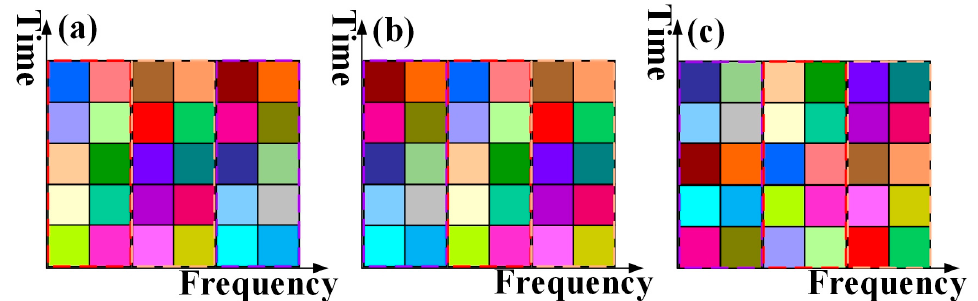
Figure 8. Schematic of the proposed digital domain encryption. ( a ) the divided frequency domain, ( b ) the disturbed frequency domain, and ( c ) the disturbed time domain.